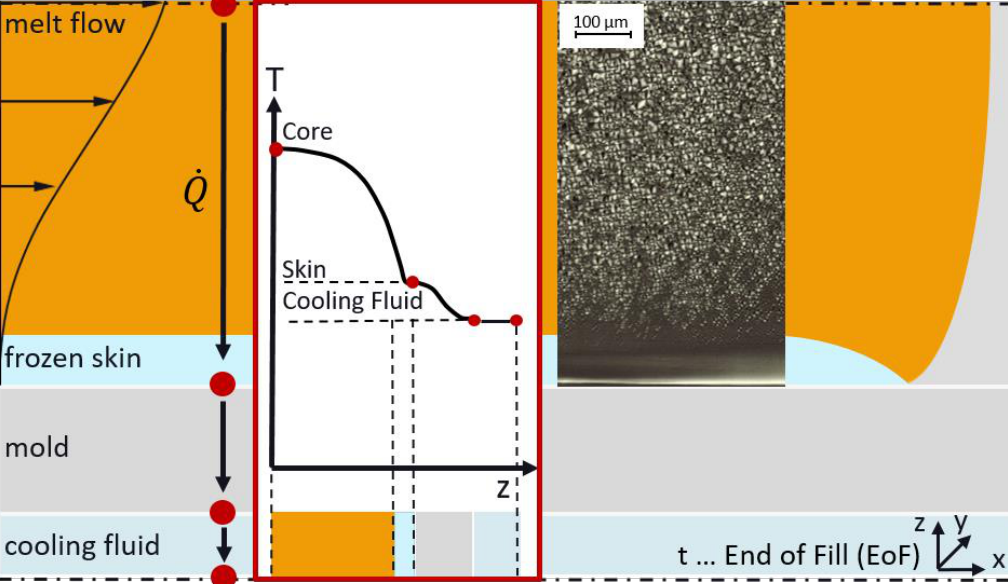
Figure 2. Melting flow scheme during injection-molding. The melt flow inside the cavity with the temperature curve from the core to the skin at the end of filling stage.